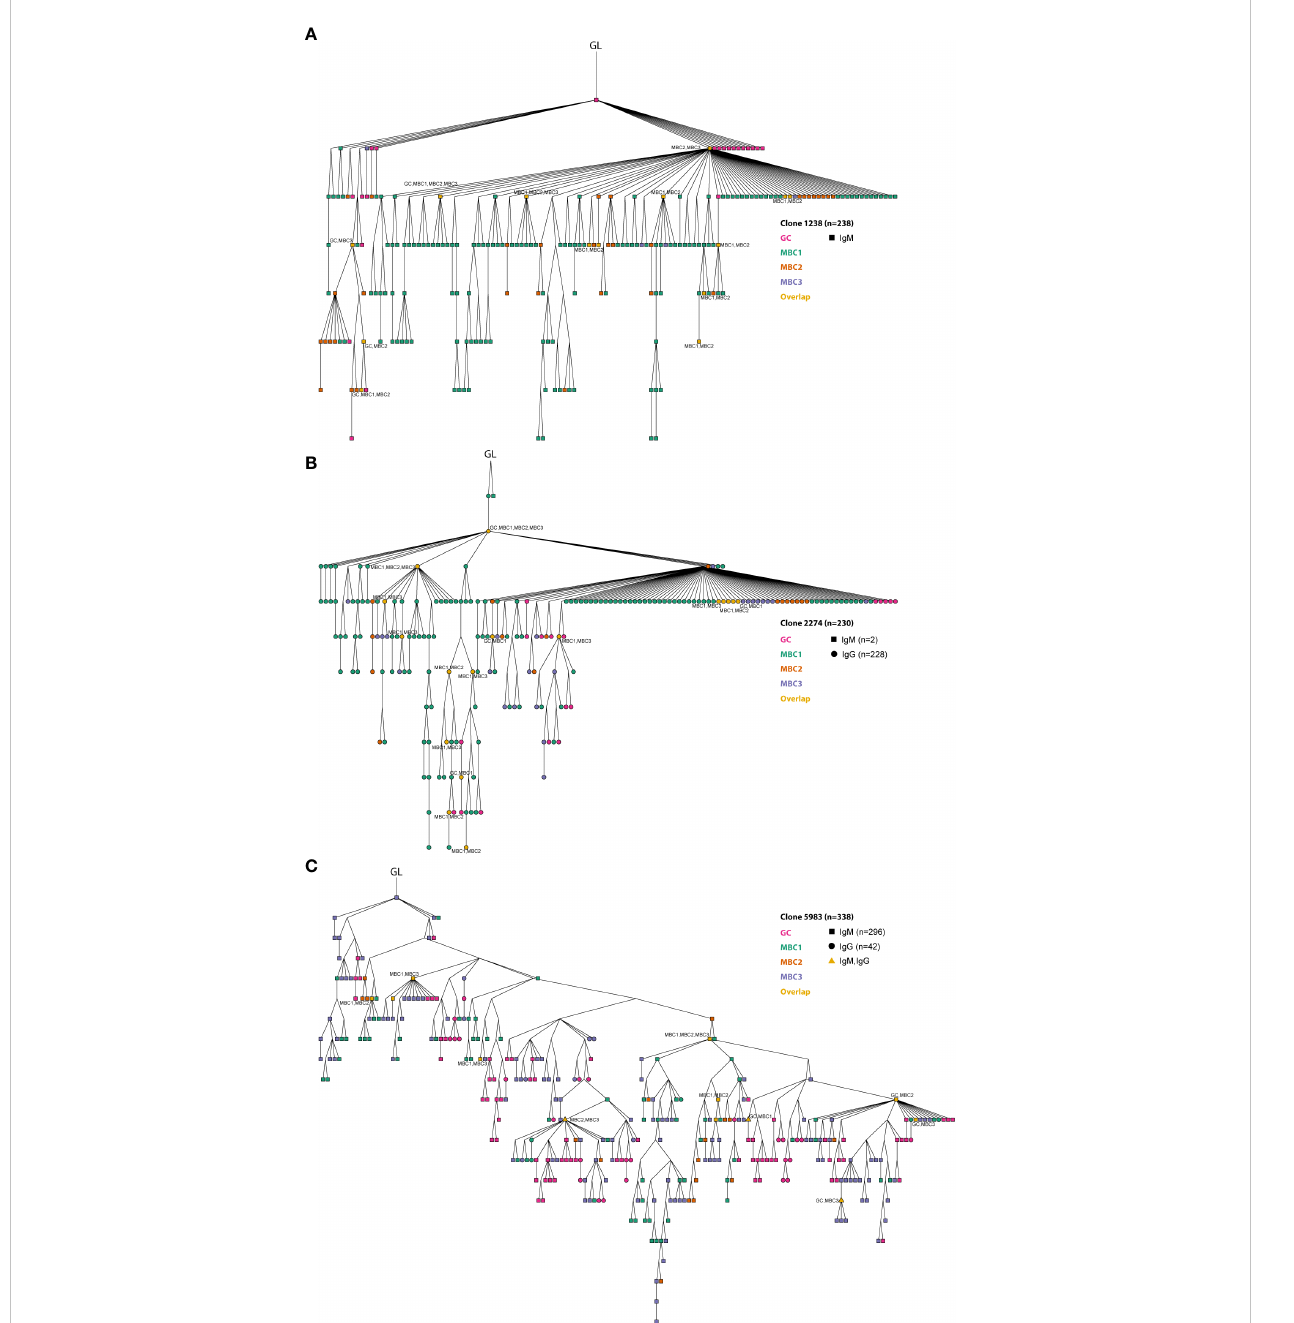
FIGURE 6 Clonal relationships between GC B cells and MBC subsets. (A – C) Three expanded clones are shown from the lineage tree analysis. Germline (GL) is indicated in the fi gure. The different MBC subsets and GC B cells are indicated in the fi gure. At certain nodes overlap between different MBC subsets and with GC B cells can be observed (in orange). Overlapping sequences for IgM and IgG are also indicated (triangle shaped). Results from a pool of 6 mice. Overlapping nodes without text are identical to those of their